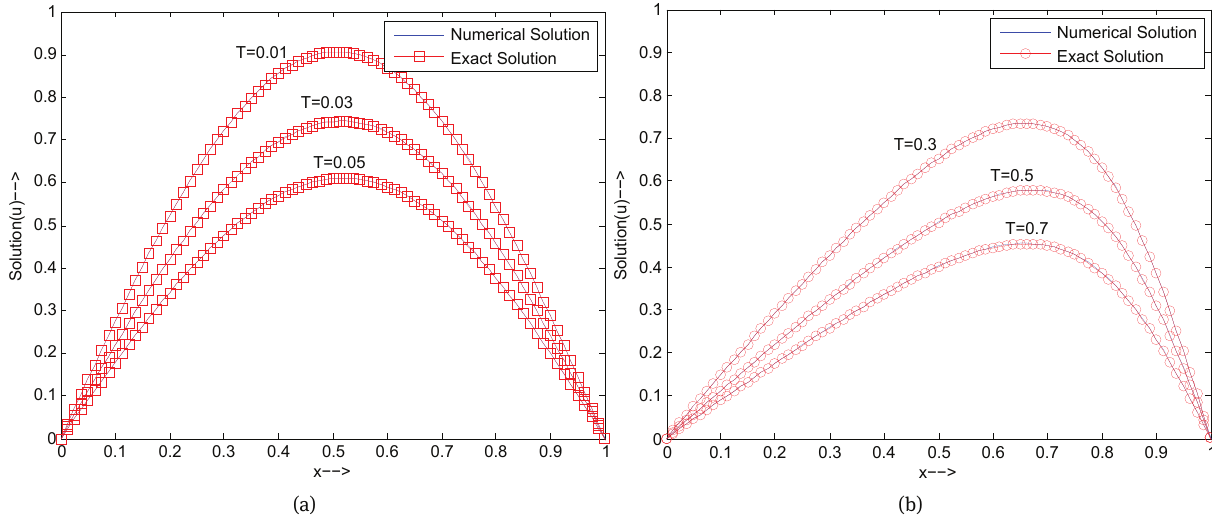
Fig. 1: Numerical solutions of Example 1 at different times for Δx = 0.0125 and different values of ν and Δt , (a) ν = 1 , Δt = 0.0001 (b) ν = 0.1 , Δt = 0.001 .